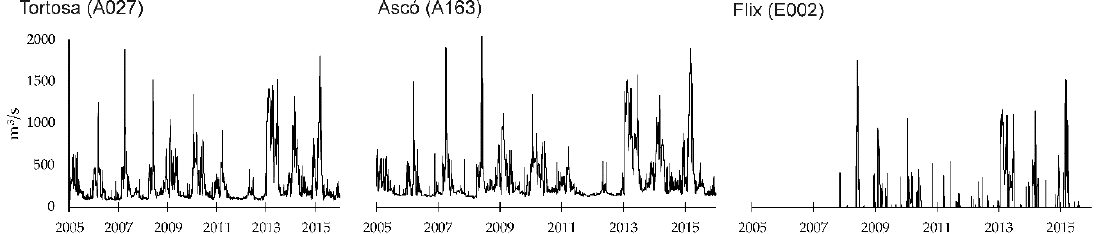
Figure 2. Flow series recorded in Tortosa (A027), Ascó (A163), and Flix (E002) from 2005 to